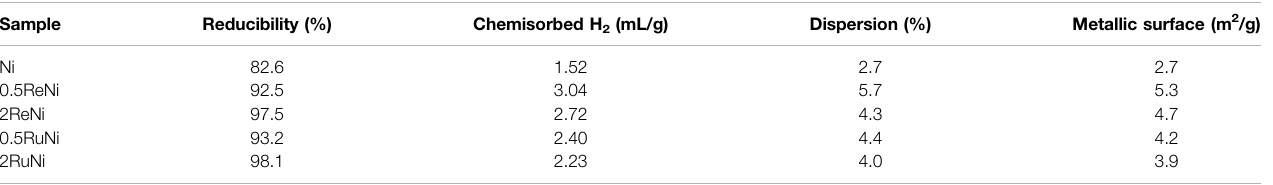
TABLE 3 | Reducibility and data extracted from the H 2 -TPD.